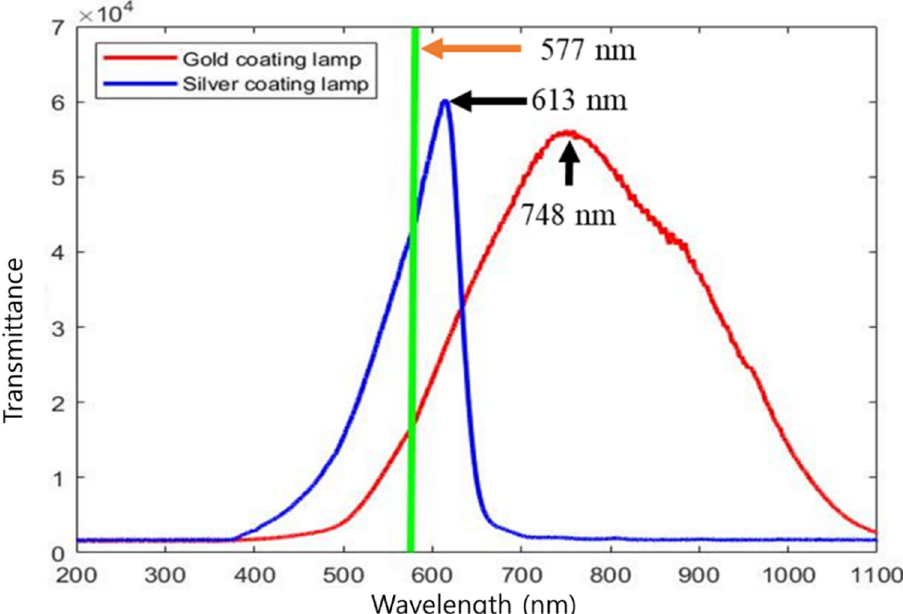
Figure 5. The light patterns of the gold-coated halogen-tungsten lamp and the silver-coated halogen-tungsten lamp.